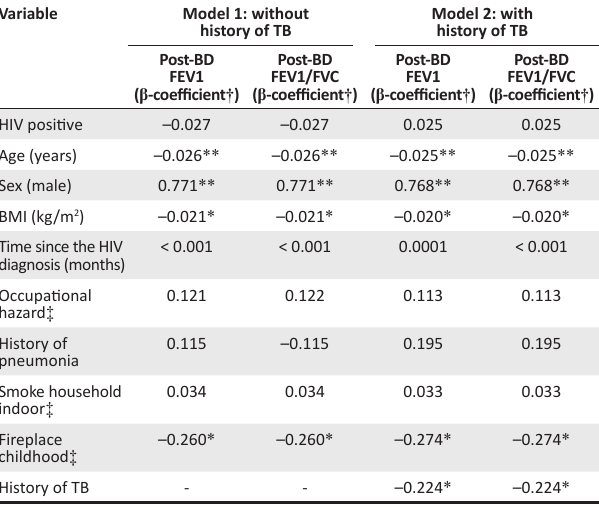
TABLE 3: Results of multivariable analysis for post-bronchodilator (BD) forced expiratory volume in 1 second and forced expiratory volume in 1 second/forced vital capacity on smoking participants.